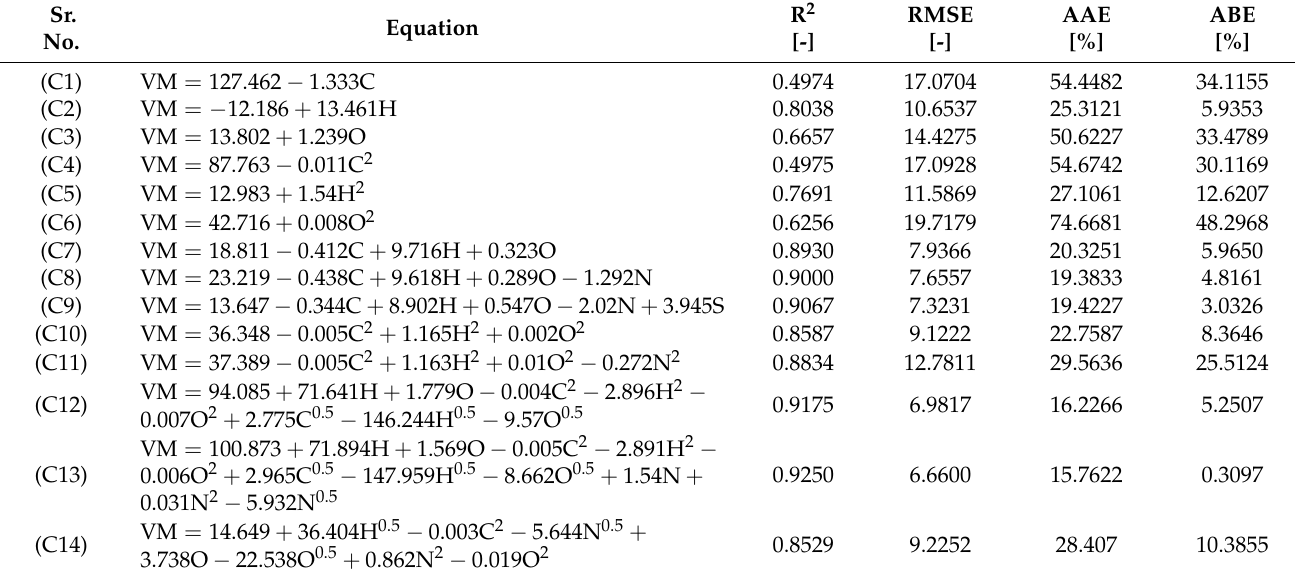
Table 3. Correlations used for predicting the VM of biomass based on element